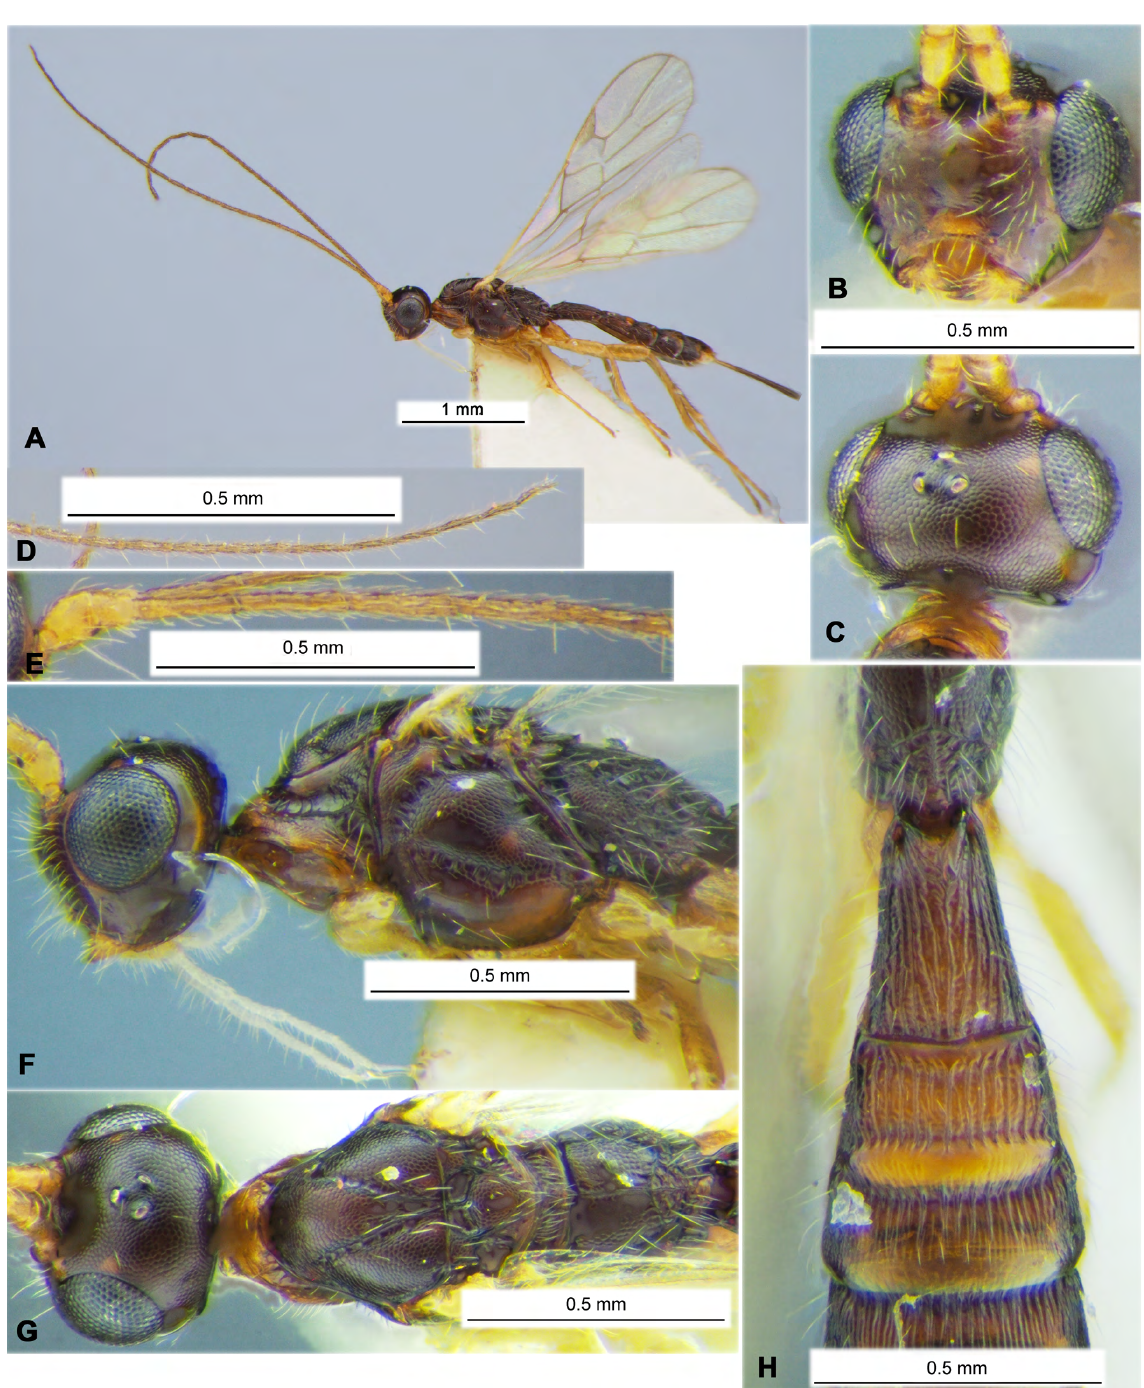
Fig. 10. Euryphrymnus basoareolus (Belokobylskij, 2001) comb. nov., ♀, holotype, ZISP. A . Habitus, lateral view. B . Head, front view. C . Head, dorsal view. D . Apical segments of antenna. E . Basal segments of antenna. F . Mesosoma, lateral view. G . Mesosoma, dorsal view. H . Propodeum and first to third metasomal tergites, dorsal